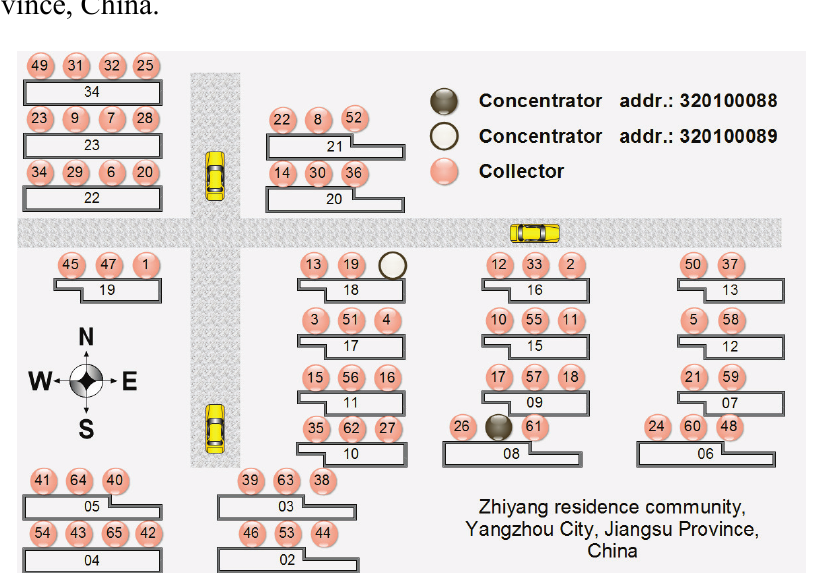
Figure 6. Two EMMNets deployed in Zhiyang residence community, Yangzhou City, Jiangsu Province,